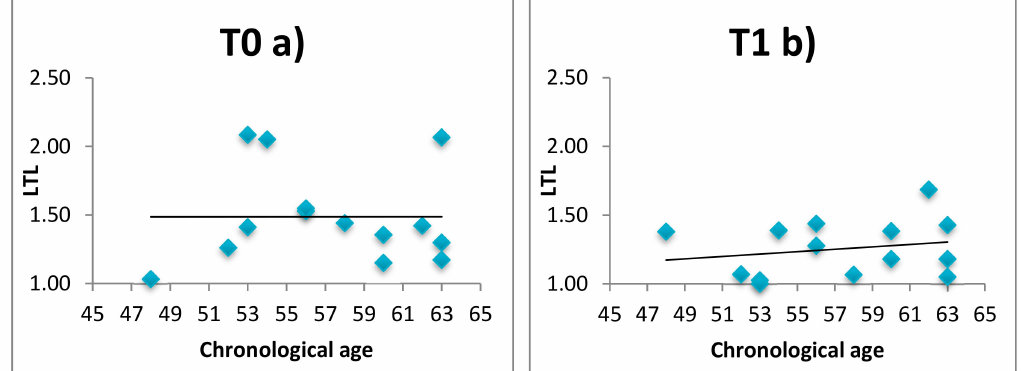
Figure 3. Comparison of the correlation curves between LTL and chronological age at enrolment T0 ( a ) versus after 60 days T1 ( b ) based on Chow’s test for patients. Chow Test F (2, 24 df) = 73,975 ( p <